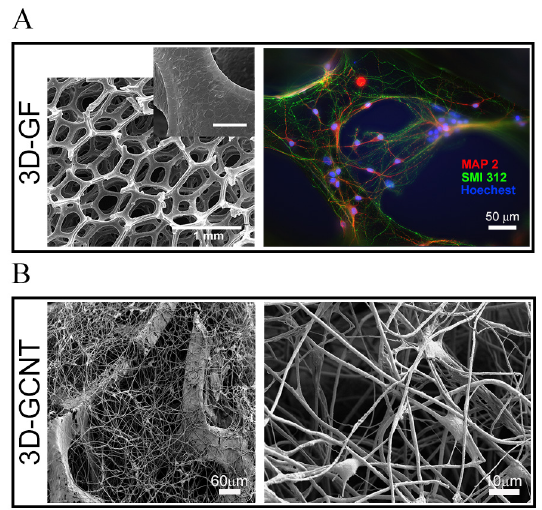
Figure 1. (A) An example of 3D-GF , on the left a scanning electron microscopic image showing the big pore size, and on the right mature neurons growing on the backbone and sometimes able to cross the pore of the structure without support. (B) An example of 3D-GCNT , on the left showing the CNT web inside the GF structure, and on the right showing the intricate web of CNT supporting the neuronal cell bodies. Modified from Ulloa Severino et al., 2016